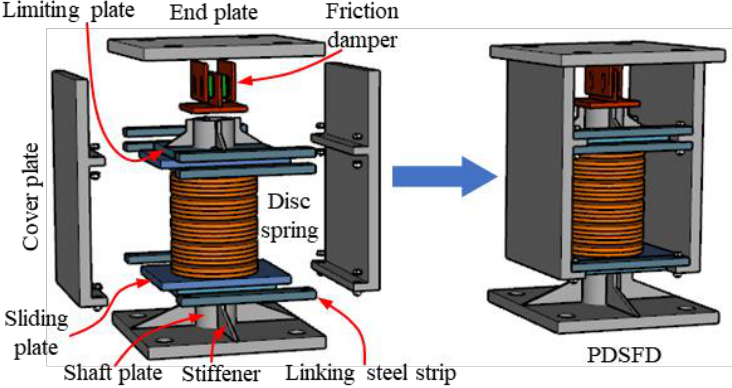
Figure 2. Schematic diagram of PDSFD.